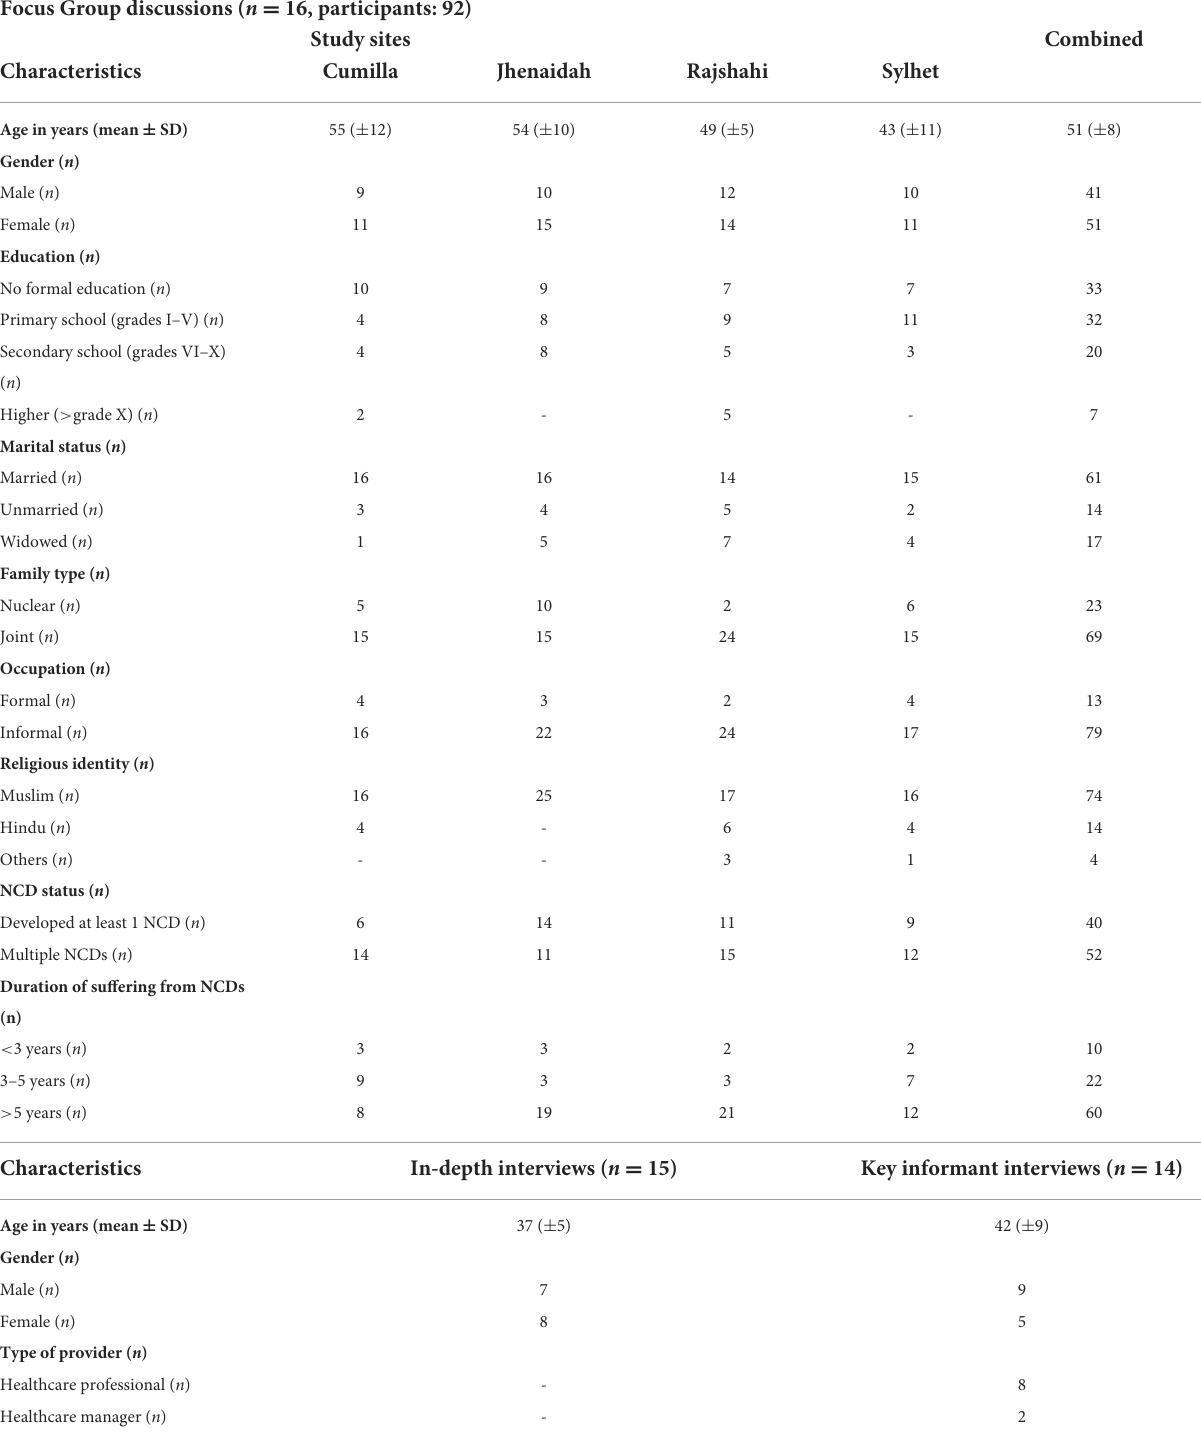
TABLE 2 Background information of participants in FGDs, IDIs, and KIIs. Focus Group discussions ( n = 16, participants: